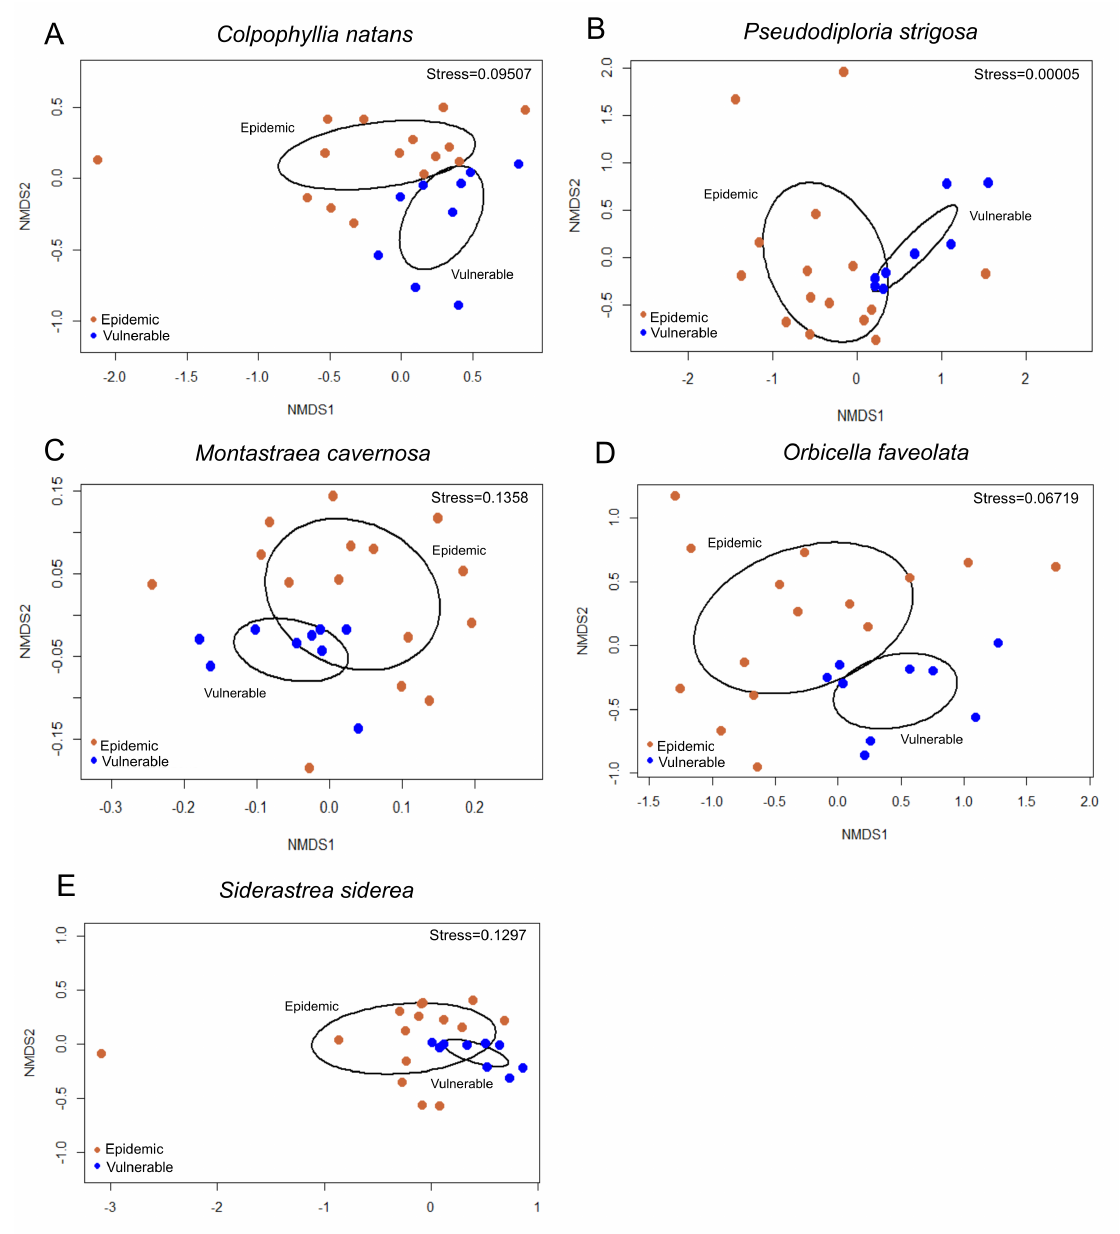
Figure 3. Non-metric Multidimensional Scaling (NMDS) ordination plots of amplicon sequence variants (ASVs) in the tissues of apparently healthy colonies of five coral species: ( A ) Colpophyllia natans , ( B ) Pseudodiploria strigosa , ( C ) Montastraea cavernosa , ( D ) Orbicella faveolata , and ( E ) Siderastrea siderea . Tissues of apparently healthy colonies were collected from the epidemic zone (orange) and the vulnerable zone (blue) of stony coral tissue loss disease. NMDS was performed using a Euclidean